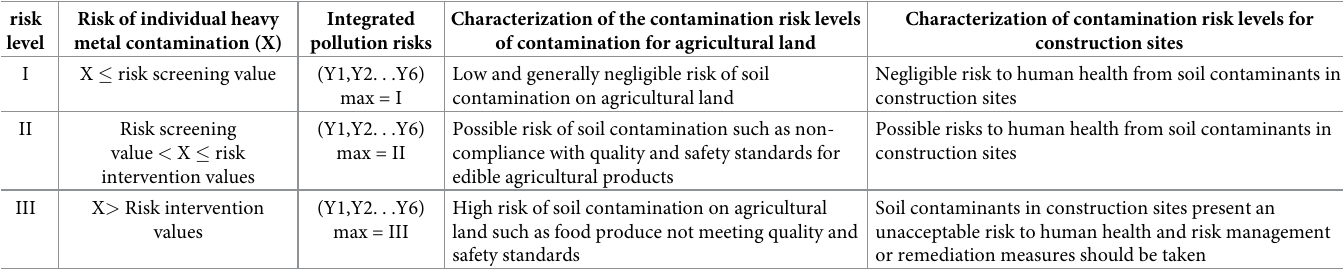
Table 2. Health risk classification criteria for heavy metal contamination of soils. risk Risk of individual heavy level metal contamination